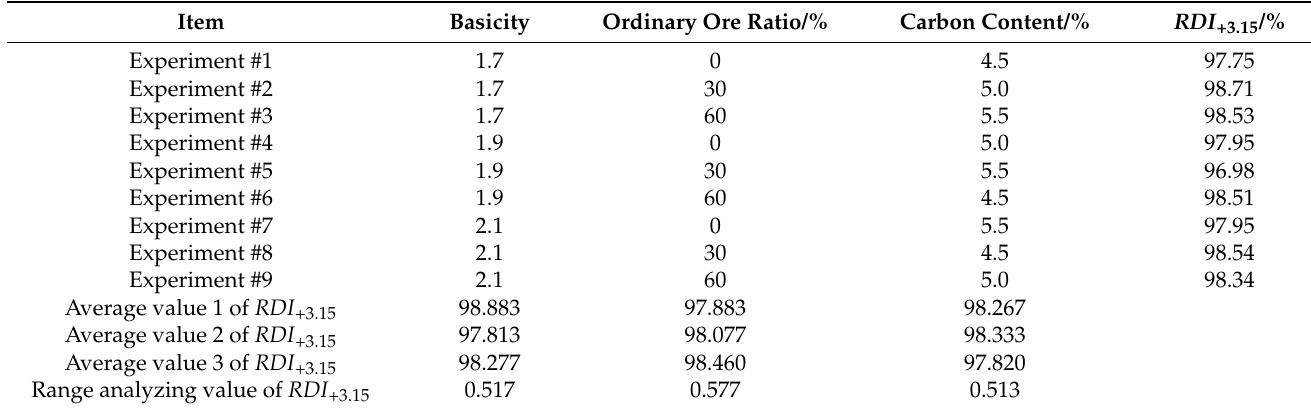
Table 11. Range analysis of low-temperature reduction and pulverization